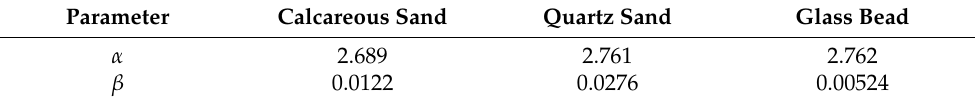
Figure 11. Fractal dimensions of the tested materials with different grain sizes. Table 2. Summaries of model parameters for carbonate-based sand and silicate-based sand. Parameter Calcareous Sand Quartz Sand Glass Bead